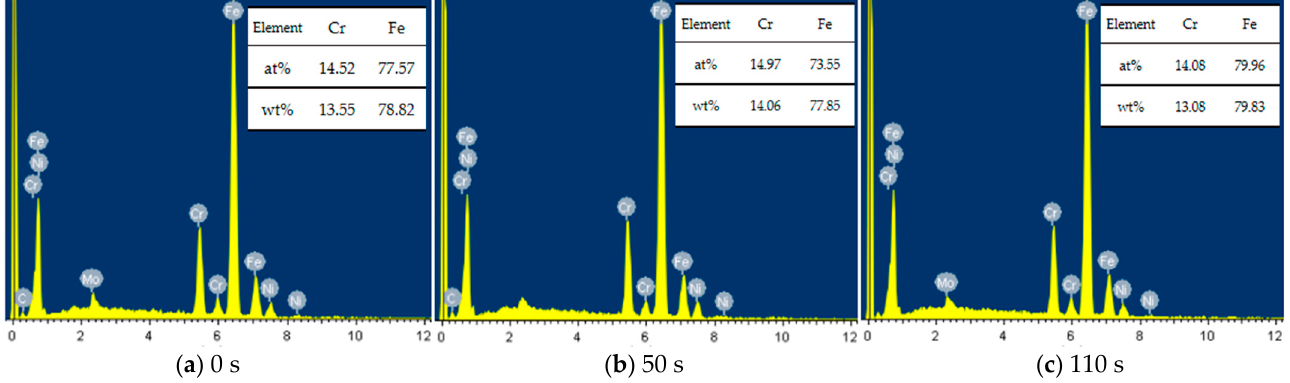
Figure 5. The EDS spectra of samples with different acid treatment durations: ( a ) 0 s; ( b ) 50 s; and ( c ) 110 s.